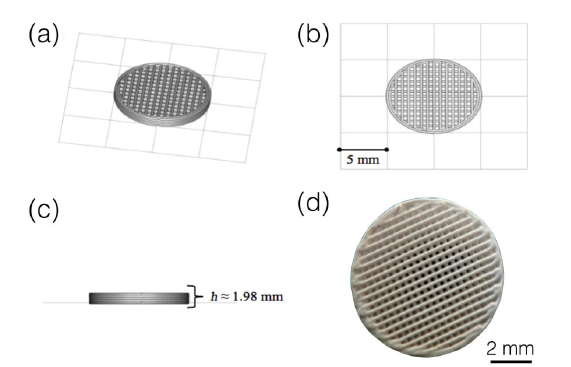
Fig. 1 Schematic of scaffold designed in RoboCAD 4.3 (3D Inks, LLC Tulsa, OK, USA): (a) isometric view, (b) top view, (c) front/side view, and (d) final scaffold after